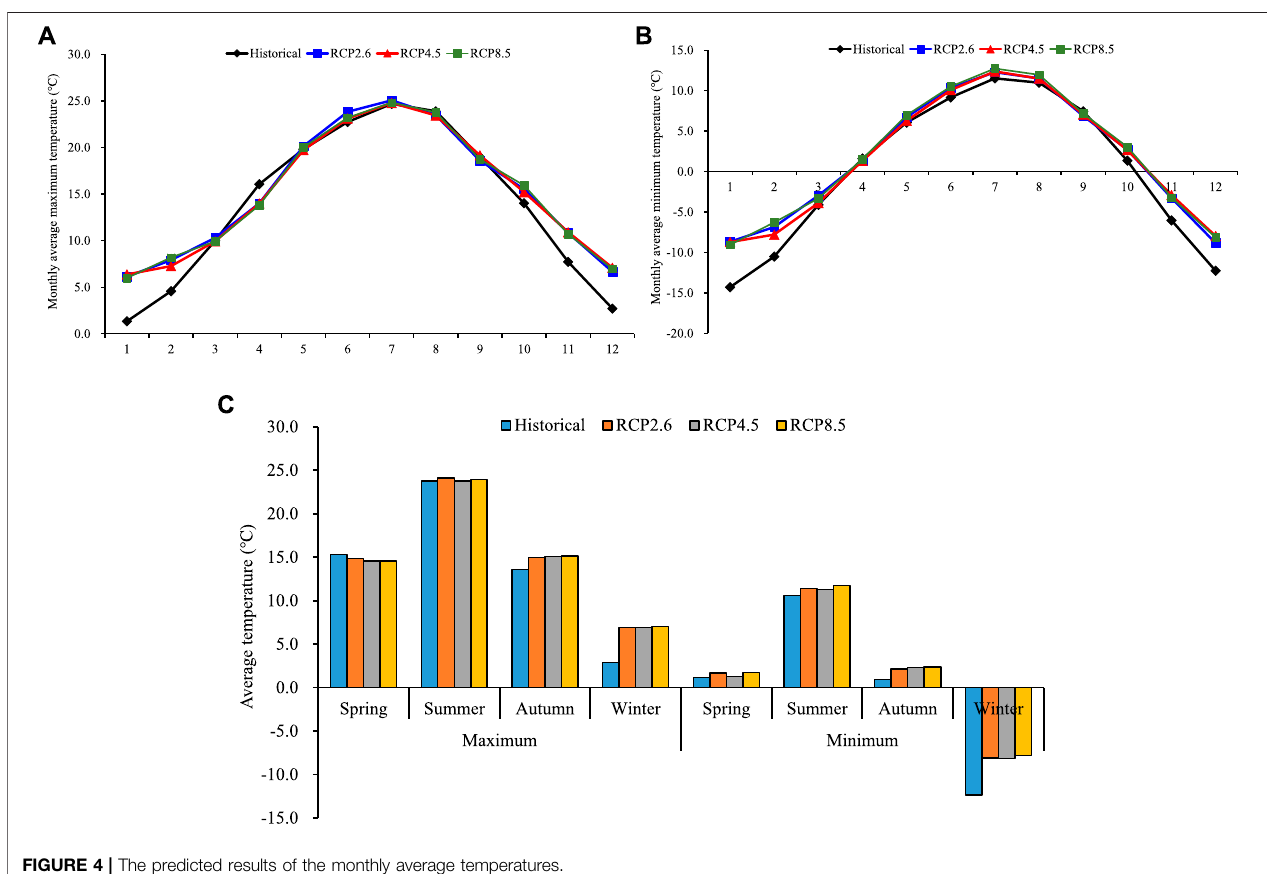
FIGURE 4 | The predicted results of the monthly average temperatures.